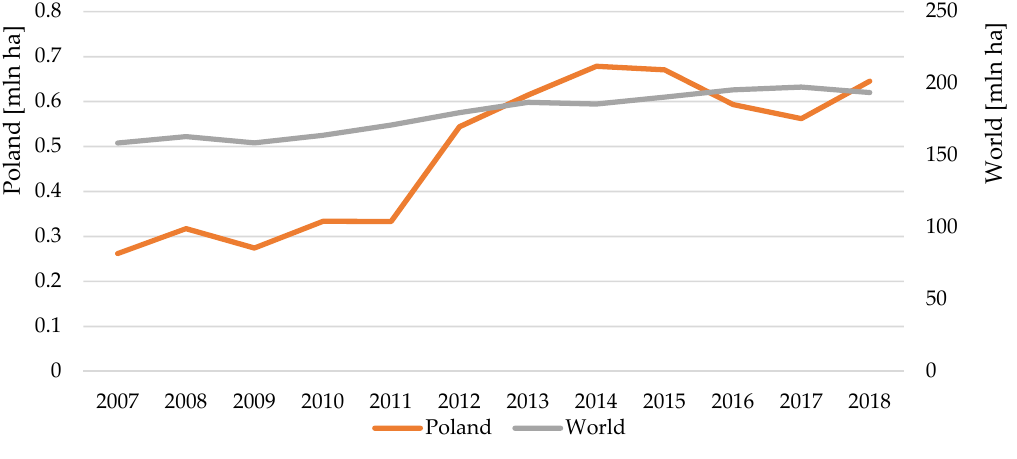
Figure 1. Maize production in 2007–2018, Source: own elaboration based on [35].